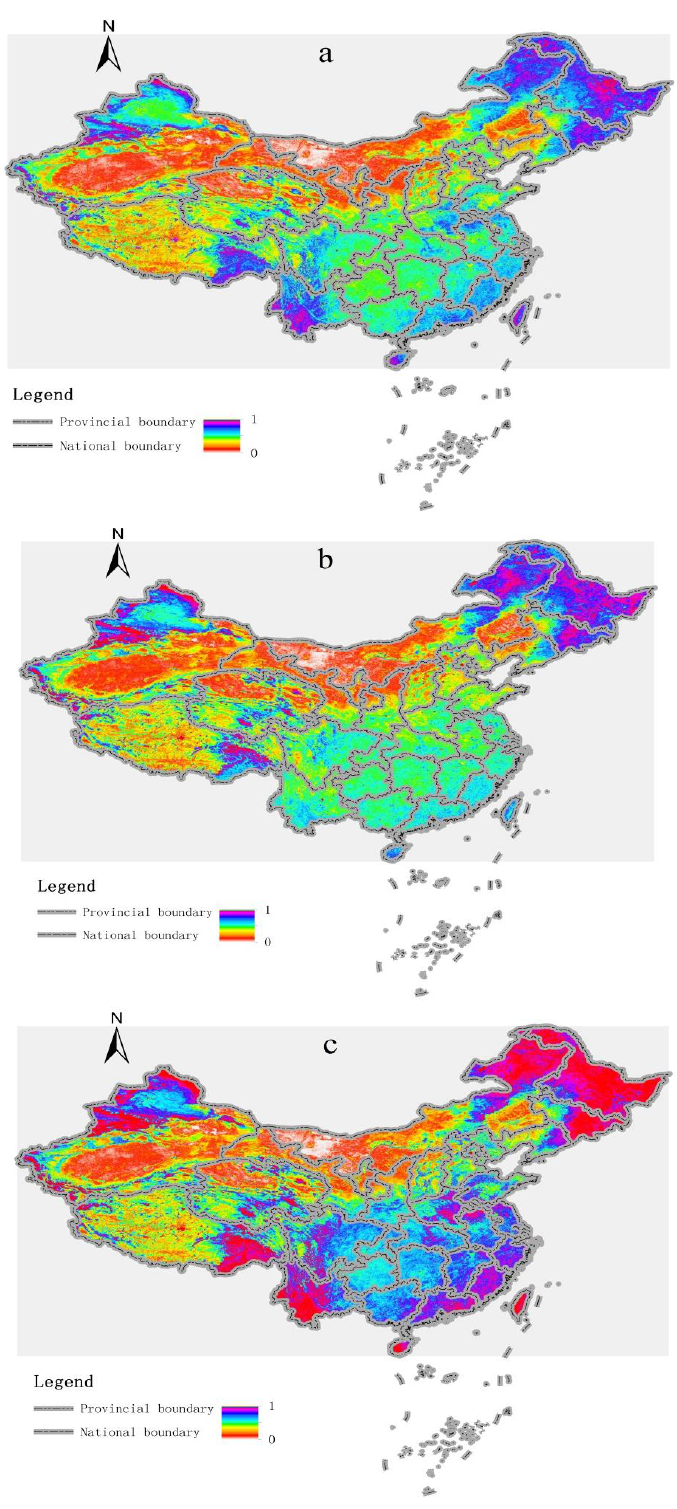
Figure 6. 2017 results from different method. We used the method of this paper ( a ) principal component analysis ( b ), and AHP ( c ) to compare RSEI in 2017.